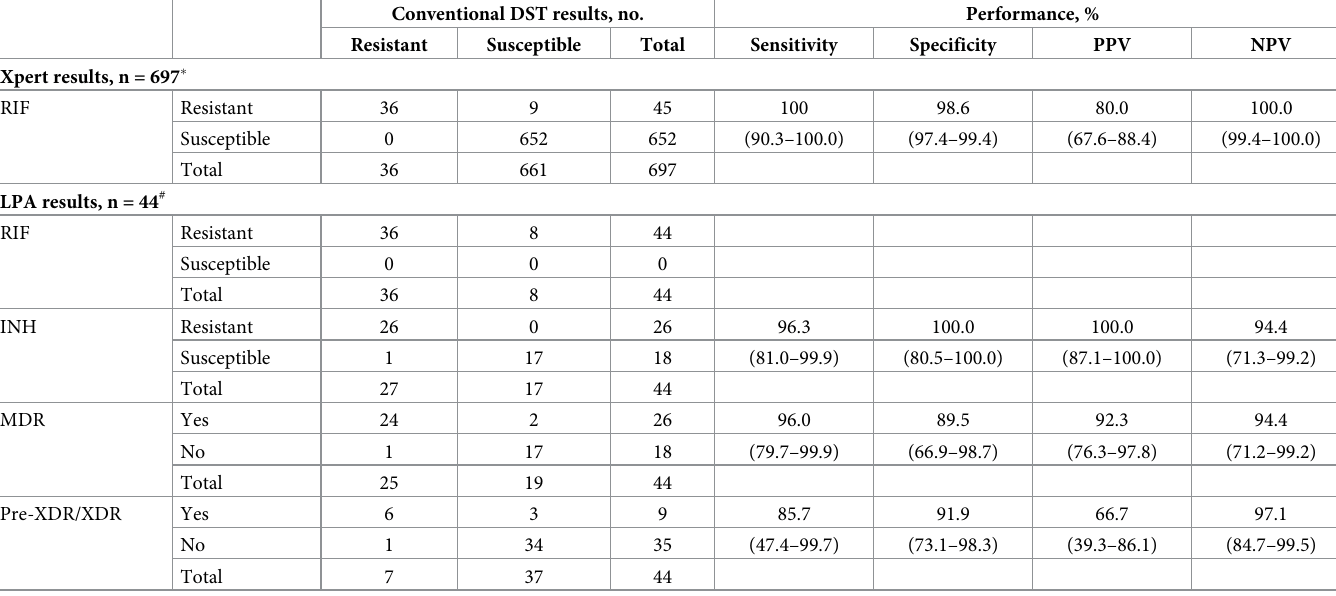
Table 3. Xpert and LPA results for drug resistance detection, compared to conventional DST results. Conventional DST results,